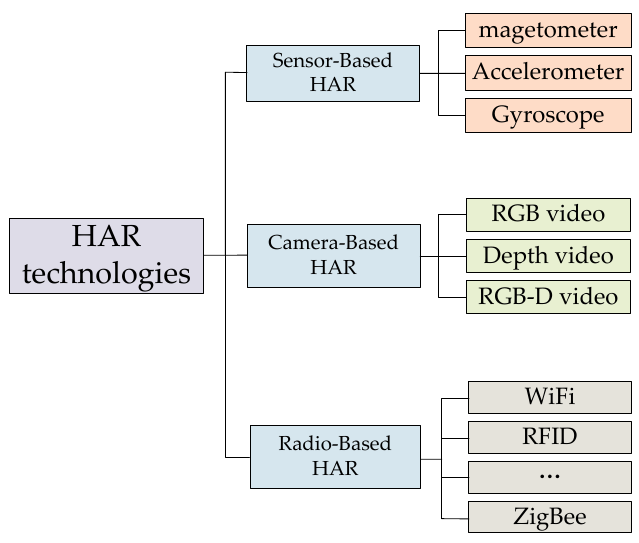
Figure 3. Categorizations of HAR systems.